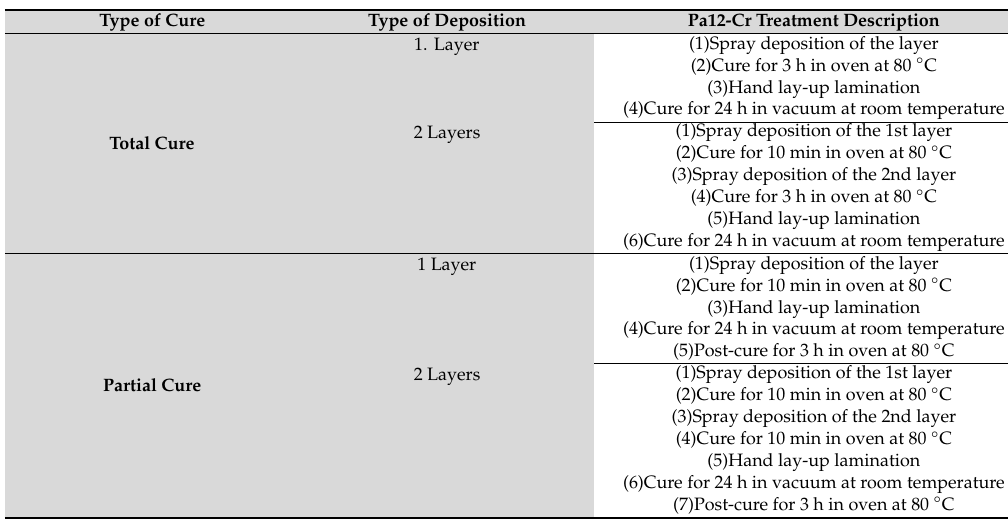
Di ff erent coupling agents curing conditions, deposition and relative PA12-CR treatment